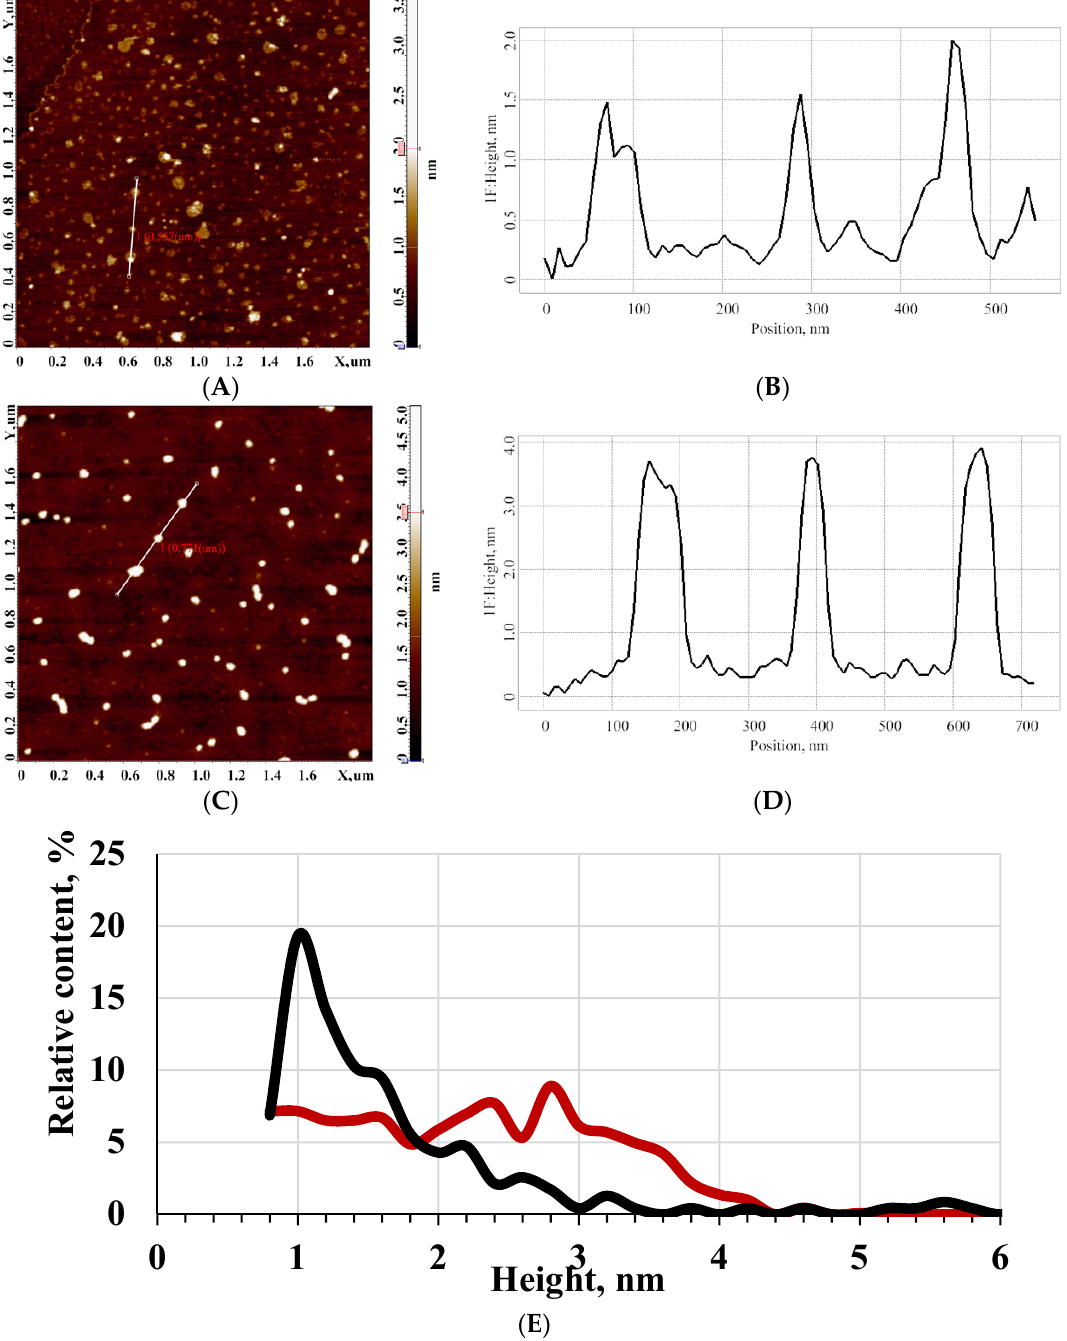
Figure 3. Results of AFM study of the effect of PEMF on the HRP aggregation. ( A – D ) Typical AFM images ( A , C ) and cross-section profiles ( B , D ) of the surface of mica substrate obtained after its incubation in 0.1 μ M aqueous HRP solution, which was either not irradiated ( A , B ) or irradiated ( C , D ) in PEMF. The cross-section profiles correspond to the lines in the respective AFM images. ( E ) Distribution plots of the AFM-visualized objects with height ρ (h) , obtained for the PEMF-irradiated (red curve) and for the control HRP solution (black curve).